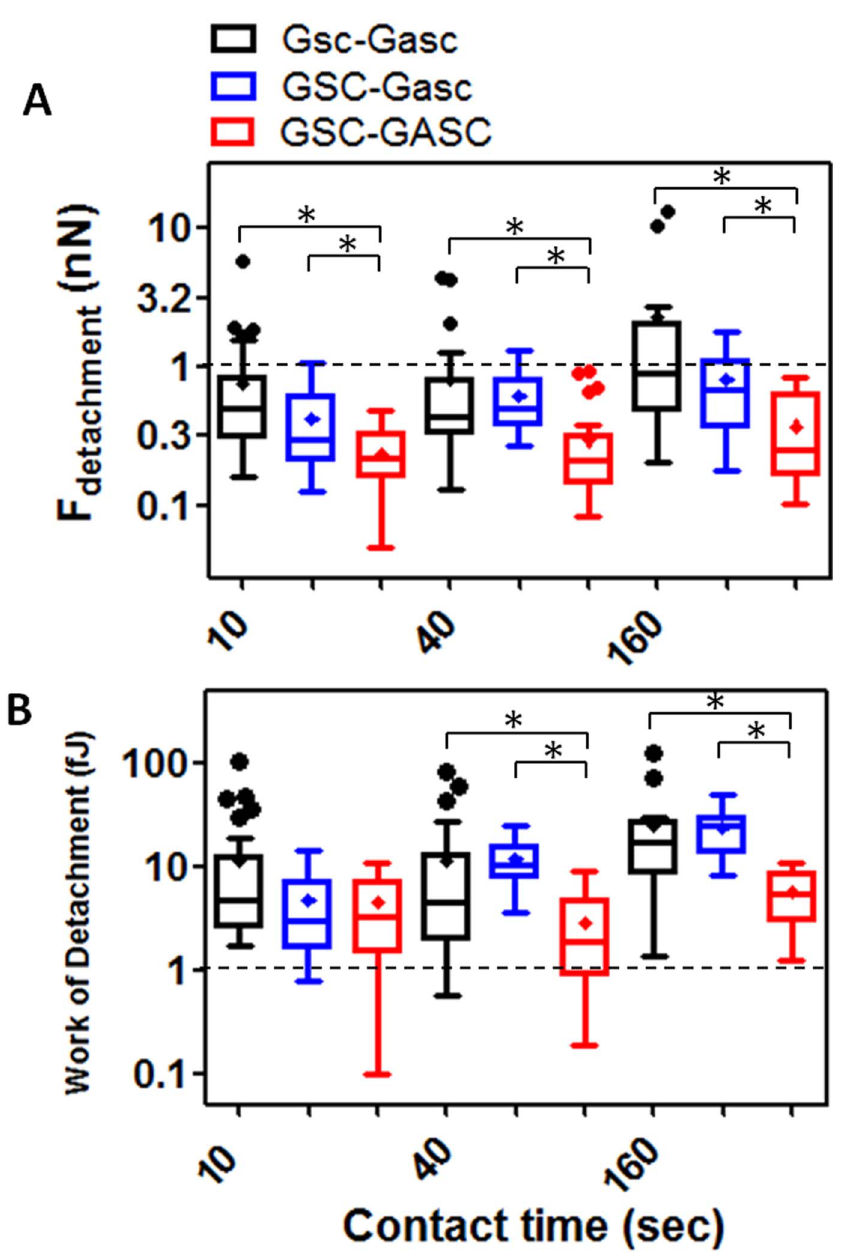
Figure 5. Interpopulation adhesion measurements. Comparison of time dependent detachment force ( A ) and work of detachment ( B ) evaluated for Gsc-Gasc, GSC-Gasc and GSC-GASC; (*) p value , 0.05 is considered statistically significant. ( A ) The detachment force of GSC-GASC is higher than that of Gsc-Gasc (p , 0.0001 at 10 sec and 40 sec, p=0.0003 at 160 sec). Detachment force of GSC-Gasc increases significantly as compared to HGG (10 sec p=0.0267; 40 sec p , 0.0001; 160 sec p=0.0014). ( B ) For work of detachment at 10 sec contact time no significant differences are detected; for higher contact time (40 sec) Gsc-Gasc is significantly higher than GSC-GASC (p=0.0068) as also the increment of GSC- Gasc as compared to GSC-GASC (p , 0.0001); for 160 sec Gsc-Gasc is significantly higher than GSC-GASC (p=0.0006) as also the increment for GSC- Gasc as compared to GSC-GASC (p , 0.0001). For a better visualization and comparison of the data, Y scale is reported as Log scale. doi:10.1371/journal.pone.0112582.g005 laminin (see Fig. 4A and B) and comparable with those observed adhesion strength of cancer cells on both their own culture for GSC on fibronectin. Indeed significant differences between substrates (laminin) and non-specific substrate (fibronectin). In GSC on GASC and GSC on fibronectin are observed only for Fig. 4 the values of detachment force and work obtained at work of detachment at 160 sec contact time. Analogous results are increasing contact time for GSC on GASC (A and B) and Gsc on obtained for the LGG form (Fig. 4C and D). The high affinity of Gasc (C and D) are plotted in comparison with data obtained for GSC and Gsc for laminin as respect to that obtained on GSC/Gsc on laminin and GSC/Gsc on fibronectin. At each fibronectin is in agreement with their inability to growth and contact time both force and work detachment of GSC on GASC proliferate on fibronectin [8]. These data suggest that cancer appear to be significantly lower than that observed for GSC on